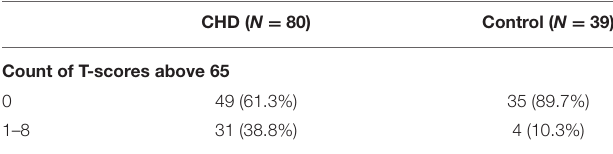
TABLE 3 | Participants at risk for an ADHD diagnosis between the CHD group and the control group. CHD ( N = 80) Control ( N = 39) Count of T-scores above